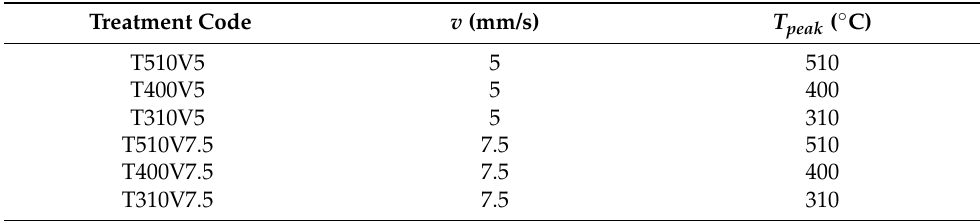
Table 3. Laser heat treatment condition.